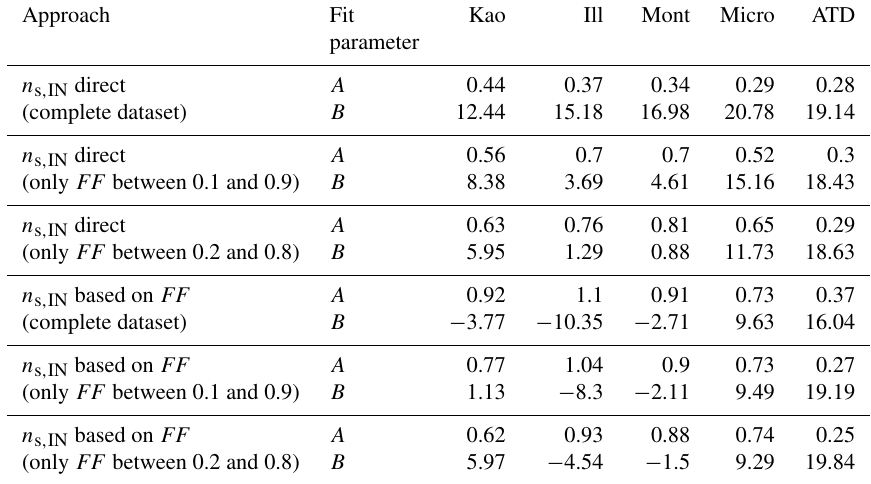
Table D1. Derived fit parameters for the deterministic n s , IN approach for different mineral dust types. The values are rounded to two digits after the decimal